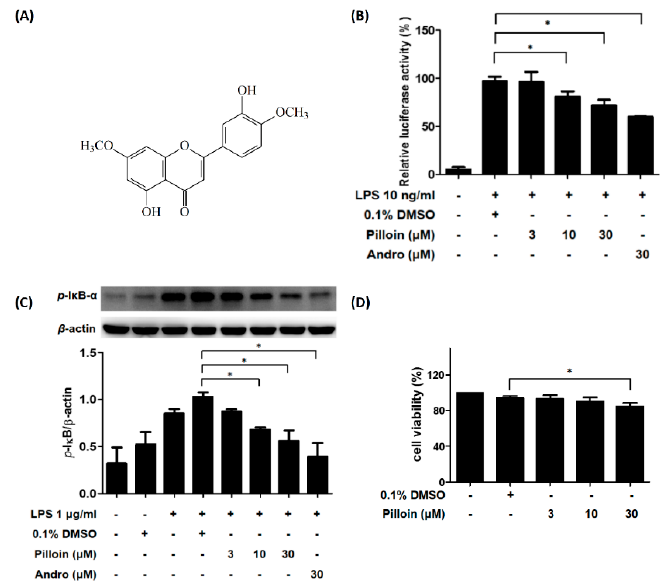
Figure 1. Pilloin inhibits NF ‐κ B activity in LPS ‐ stimulated RAW 264.7 macrophages. ( A ) Structure of pilloin (3 ′ ,5 ‐ dihydroxy ‐ 4 ′ ,7 ‐ dimethoxyflavone). ( B ) Pilloin inhibits NF ‐κ B activity in a concentration ‐ dependent manner. RAW 264.7/Luc ‐ P1 macrophages (4 × 10 5 cells in MP ‐ 24 plates) were treated with pilloin or 0.1% DMSO for 1 h, followed by LPS (10 ng/mL) for 6 h. ( C ) Pilloin reduces LPS ‐ induced I κ B phosphorylation. RAW 264.7 macrophages (10 6 cells in MP ‐ 6 plates) were treated with pilloin or 0.1% DMSO for 6 h, followed by LPS (1 μ g/mL) for 30 min. I κ B phosphorylation and β‐ actin expression were examined by Western blot analysis. β‐ actin served as the loading control. ( D ) Pilloin shows low cytotoxicity on RAW 264.7 macrophages. RAW 264.7 cells (2 × 10 4 cells in MP ‐ 96 plates) were treated with pilloin or 0.1% DMSO for 24 h and subjected to the MTT assay. 0.1% DMSO served as the vehicle control. Andro (andrographolide) served as the positive control. * indicates a significant difference versus control groups ( p < 0.05).